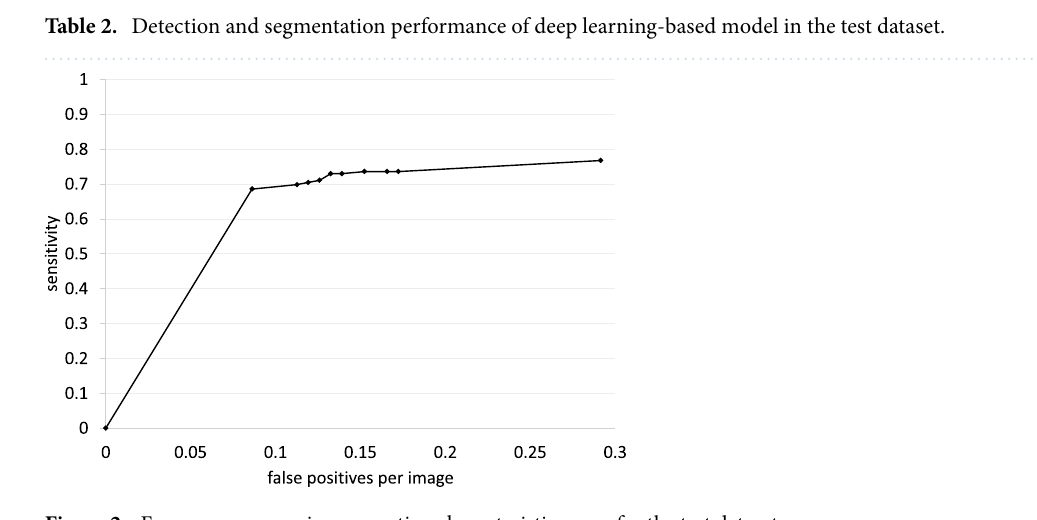
Figure 2. Free-response receiver-operating characteristic curve for the test